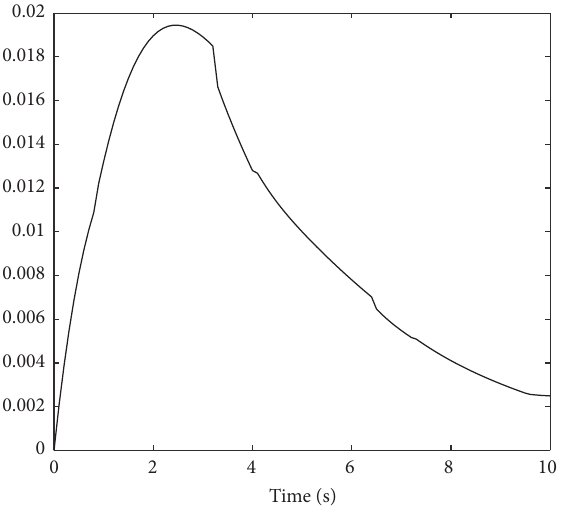
Figure 3: The evolution of 𝑦 𝑇 (𝑡)𝛿 of system